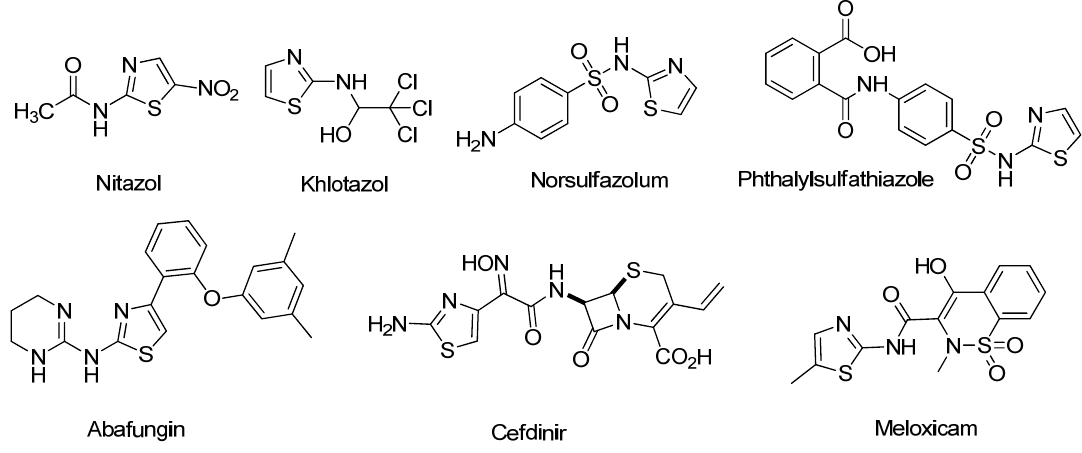
Figure 1. Derivatives of 2-aminothiazole used in medicine and veterinary medicine. In addition, the 2-aminothiazole molecule has a large number of reaction centers (endocyclic nitrogen atom, exocyclic NH 2 and the carbon atom in Position 5, Figure 2), which prompts additional interest of research chemists in this compound.